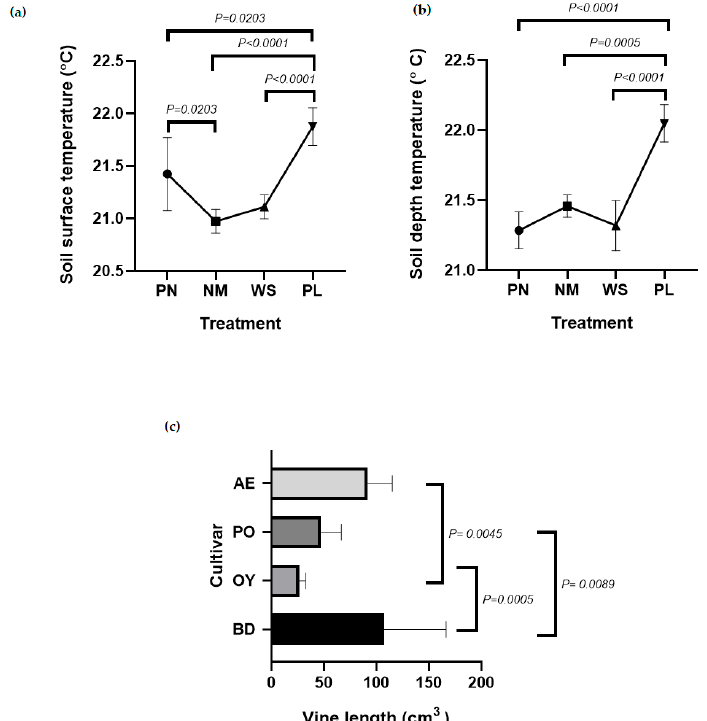
Figure 4. Soil temperature was influenced various mulch treatments (No mulch (NM), Black Plastic Mulch (PL), Pine Needle Mulch (PN) and Wheat Straw Mulch (WS) and cultivars (Beauregard (BD), O’ Henry (OY), Porto Rico (PO) and All Purple (AE)) varied in vine length ( a ) Soil surface temperatures in various mulch treatments, ( b ) Soil depth temperatures below the various mulches, ( c ) Vine lengths of di ff erent sweetpotato